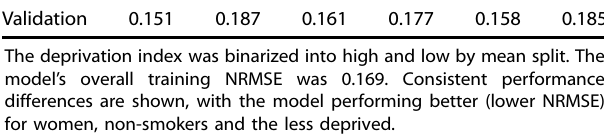
Fig. 3 Relationship of diabetes and glycated haemoglobin (HbA1c). Those without diabetes tended to have HbA1c below the diagnosis threshold of 48, while those with diabetes had a wide range of HbA1c both above and below the threshold.